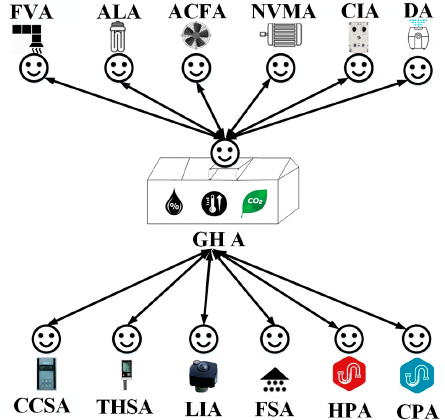
Figure 4. Multi-agent configuration of greenhouse.